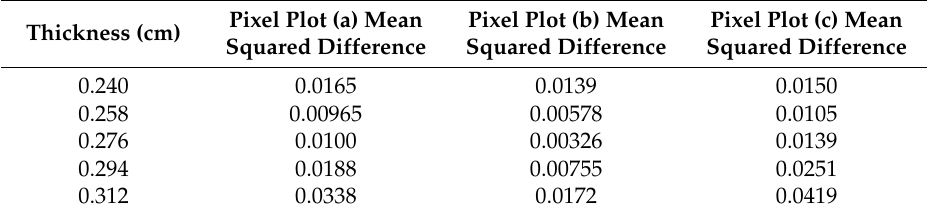
Figure 19. Temporal pixel plot comparison to model response for large area delamination at various locations. Table 4. Temporal plot comparison of model to the thermal